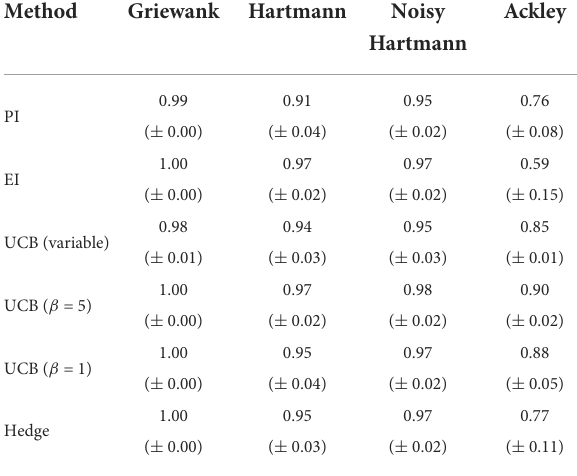
TABLE 2 Averaged area under the curve with standard error for analytical single-point acquisition functions with five initial training points per input